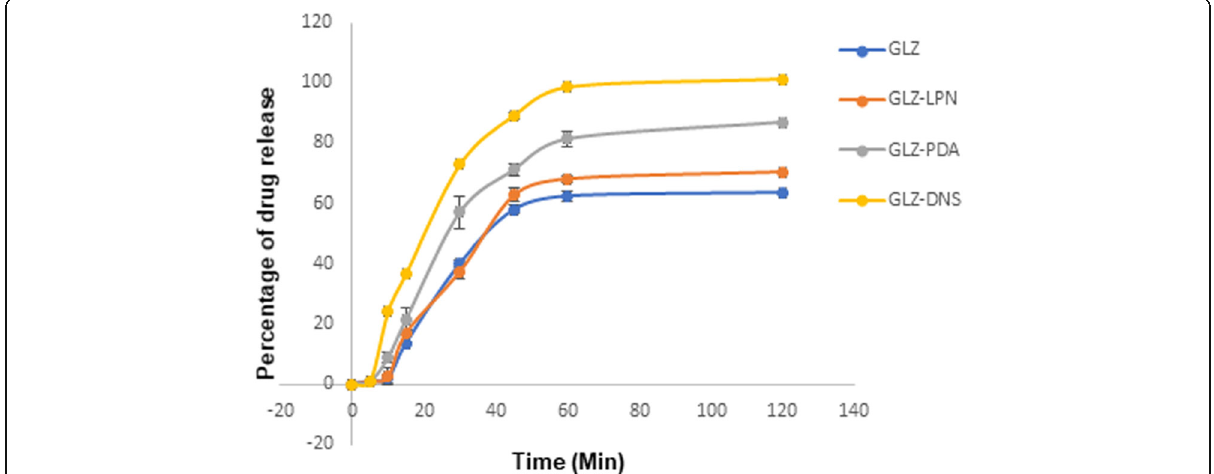
Fig. 8 Drug release profiles of GLZ, GLZ-DNS, GLZ-PDA, and GLZ-LPN